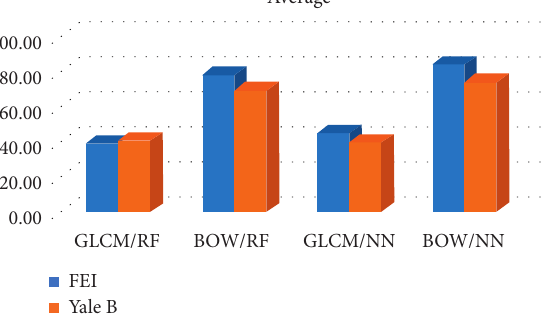
Figure 15: The average accuracy rate series of experiments on GLCM and BOW using the FEI and Yale B datasets.